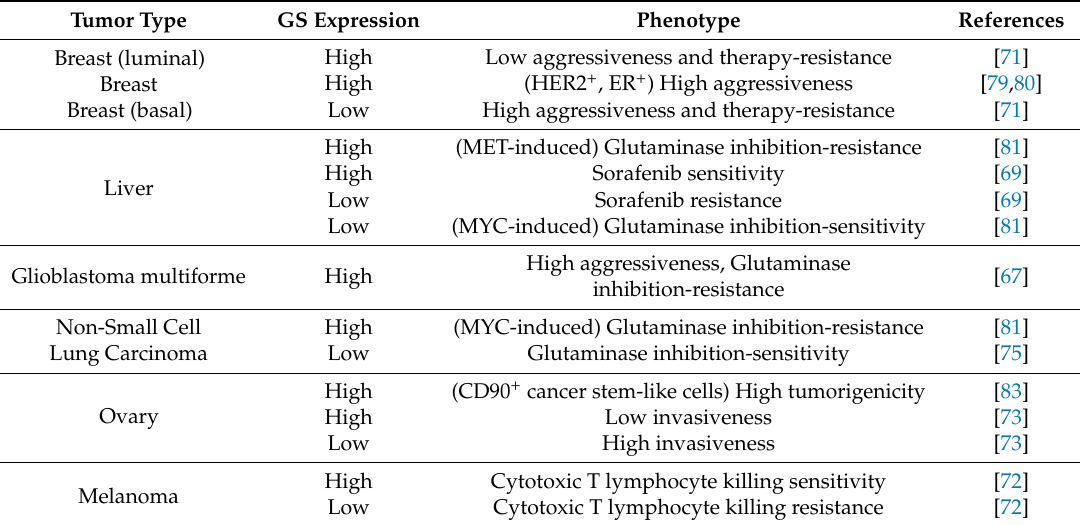
Table 1. The complexity of glutamine synthetase (GS) expression in cancer